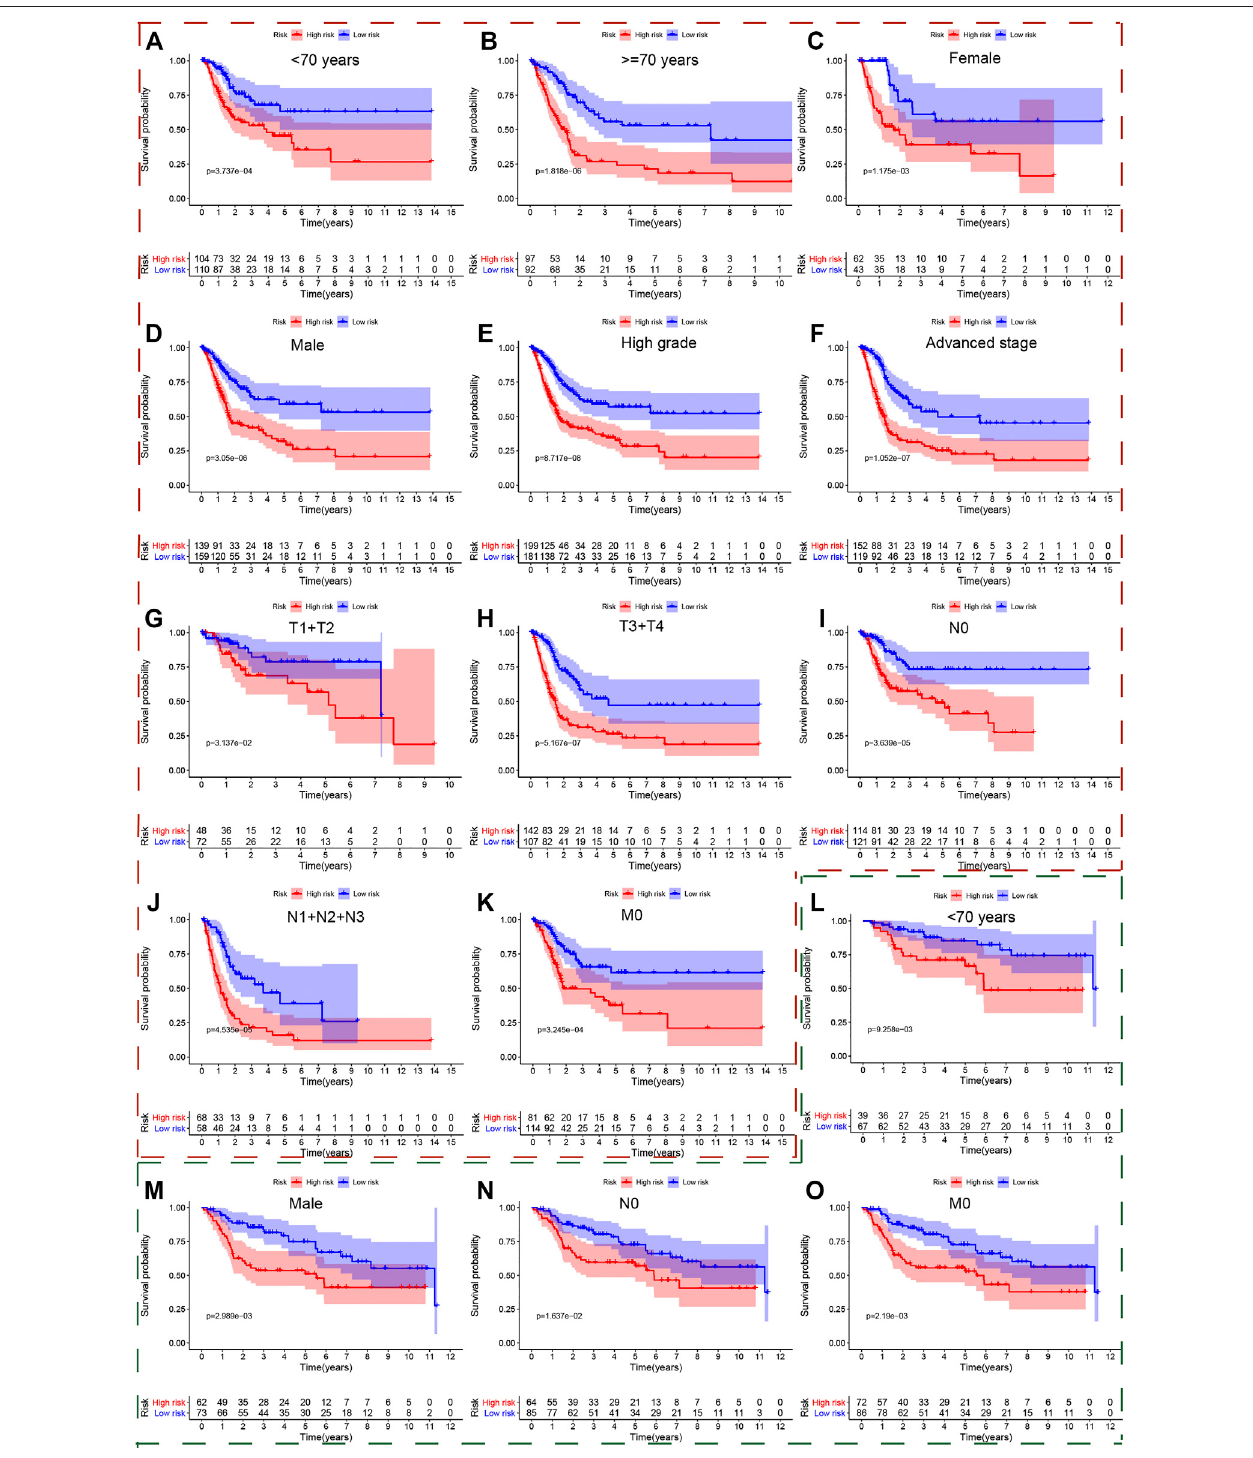
FIGURE5| ThesurvivaloutcomesofbladdercancerpatientswithdifferentriskscoresinsubgroupsofclinicopathologicalparametersintheTCGAandGSE13507. The red and green, dashed boxes corresponded to the subgroups in the TCGA and GSE13507, respectively. Patients with higher risk scores had worse overall survival compared with those with lower risk scores in subgroups for (A) age < 70, (B) age ≥ 70, (C) female, (D) male, (E) high grade, (F) advanced-stage, (G) low T-stage, (H) high T-stage, (I) nodal metastasis-free, (J) nodal metastasis, and (K) metastasis-free in the TCGA; and in the subgroups (L) age < 70, (M) male, (N) nodal metastasis-free, (O) metastasis-free in